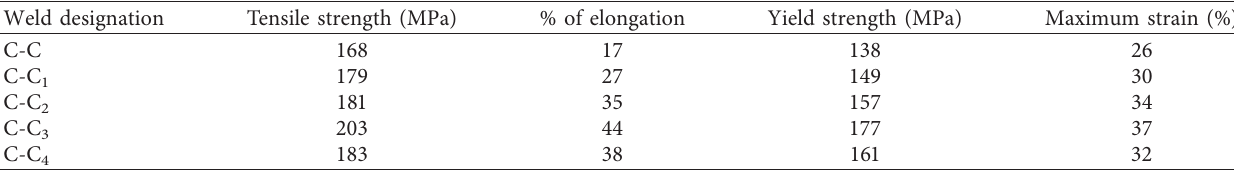
Table 4: Mechanical properties of the FSW welds.